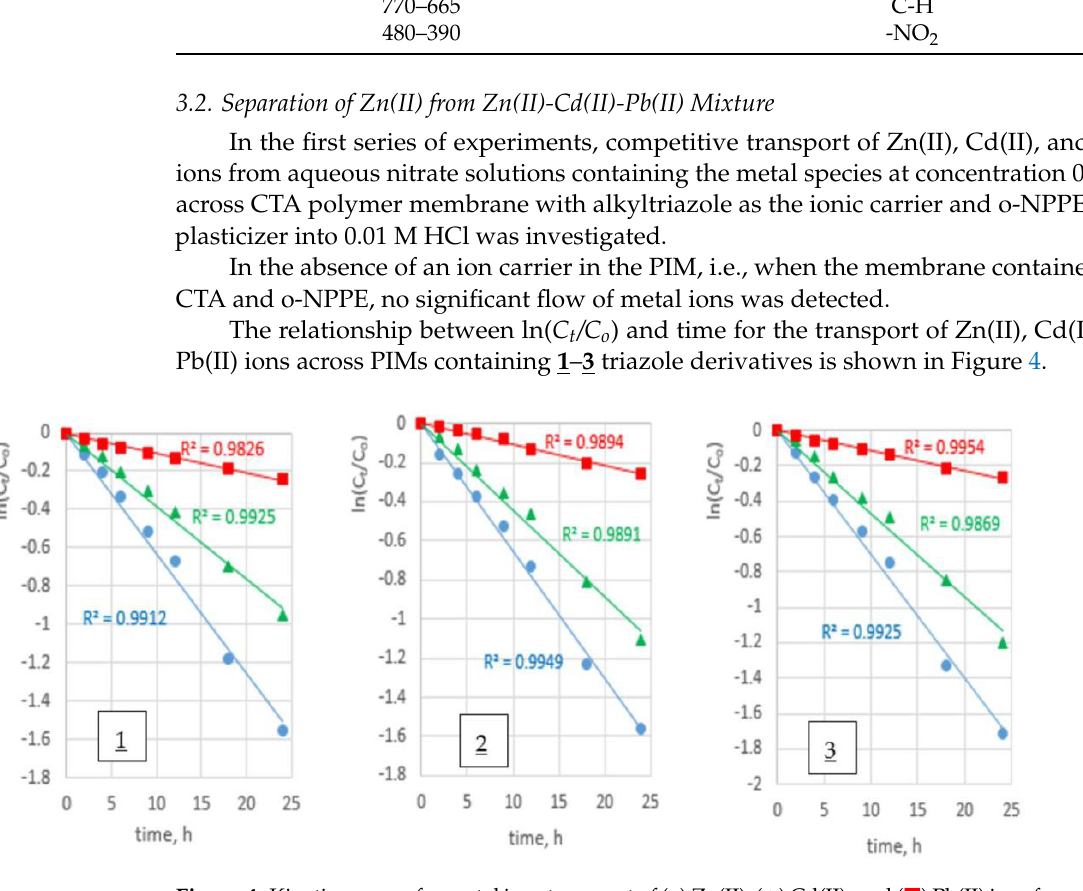
Figure 4. Kinetics curves for metal ions transport of ( • ) Zn(II), ( (cid:78) ) Cd(II), and ( (cid:4) ) Pb(II) ions from equimo- lar mixture of metal ions across PIMs with 1–hexyltriazole ( 1 ), 1–octyltriazole ( 2 ), and 1–decyltriazole ( 3 ); feed phase: CM = 0.001 M each metal ion, pH = 4.0; receiving phase: 0.01 M